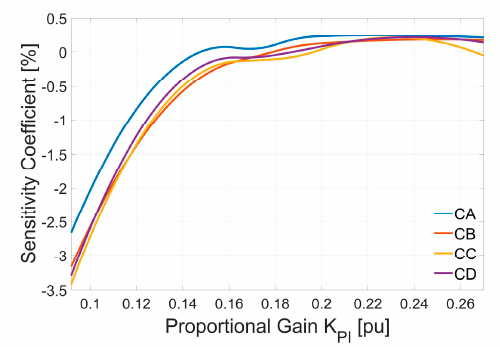
related to K AVR variations.